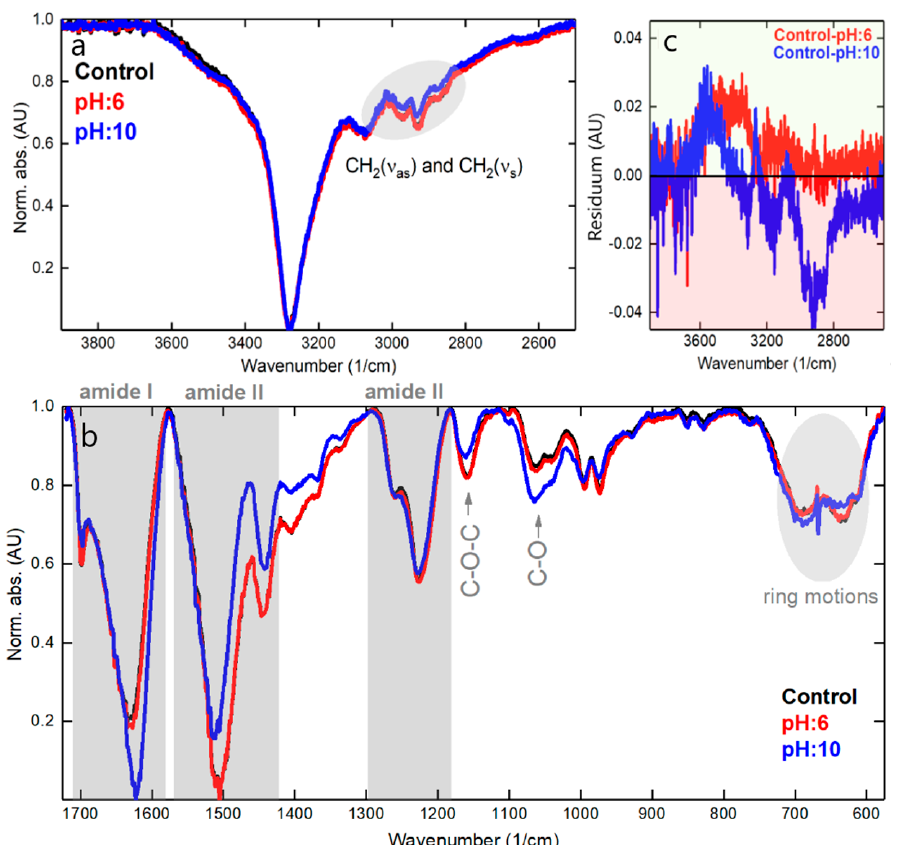
Figure 10. FTIR spectra ( a , b ) for the selected samples accompanied by residuum graph ( c ) for CH, NH, and OH stretching.